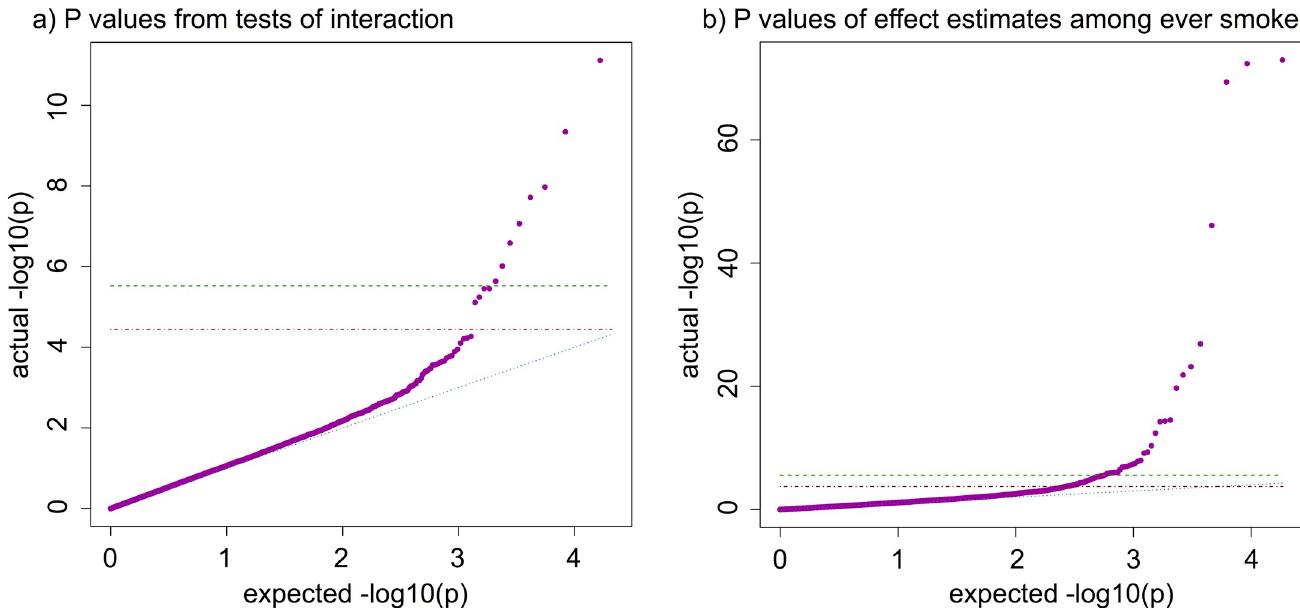
Fig 2. QQ plots of PHESANT MR-pheWAS results. Green dashed: Bonferroni corrected threshold; Red dash-dotted: 5% false discovery rate (FDR) threshold; Blue dotted: Expected = Actual; Purple points: results of tests performed: a) P-values of tests of interaction in GxE MR-pheWAS, and b) P-values of SNP-outcome associations in MR-pheWAS among ever smokers. Multiple testing thresholds: a) Bonferroni threshold: 0.05/16692 = 3.00x10 -6 ; 5% FDR threshold: 0.05x12/ 16692 = 3.59x10 -5 , and b) Bonferroni threshold: 0.05/18513 = 2.70x10 -6 ; 5% FDR threshold: 0.05x69/18513 = 1.86x10 -4 .